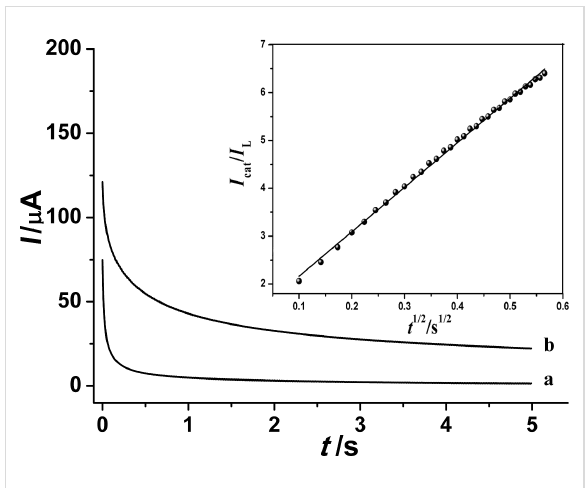
Figure 4: Chronoamperograms of PGA/MWCNT/GCE in 0.2 M phos- phoric acid in absence (curve a) and presence (curve b) of 1.0 mM GA; the inset shows the relationship of I cat / I L versus t 1/2 .